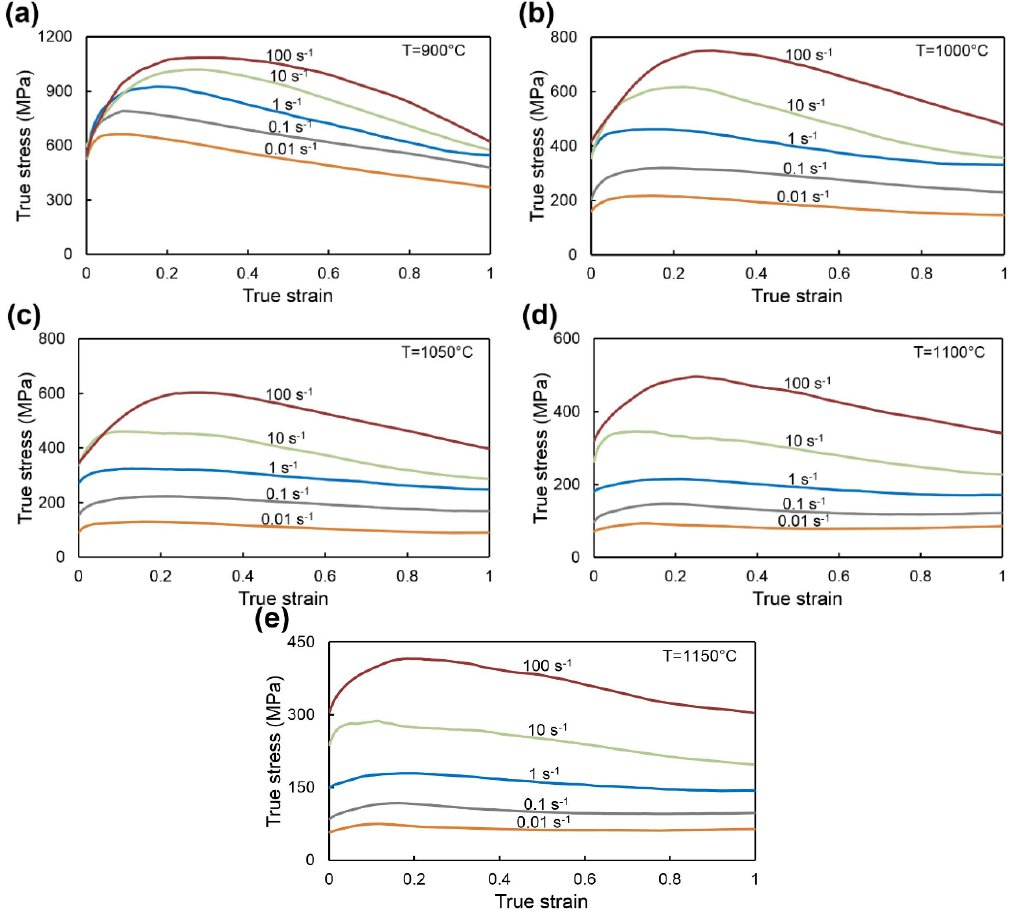
Figure 2. The typical flow stress curves for Waspaloy obtained in compression tests at different strain rates and temperatures: ( a ) 900 °C; ( b ) 1000 °C; ( c ) 1050 °C; ( d ) 1100 °C; ( e ) 1150 °C.